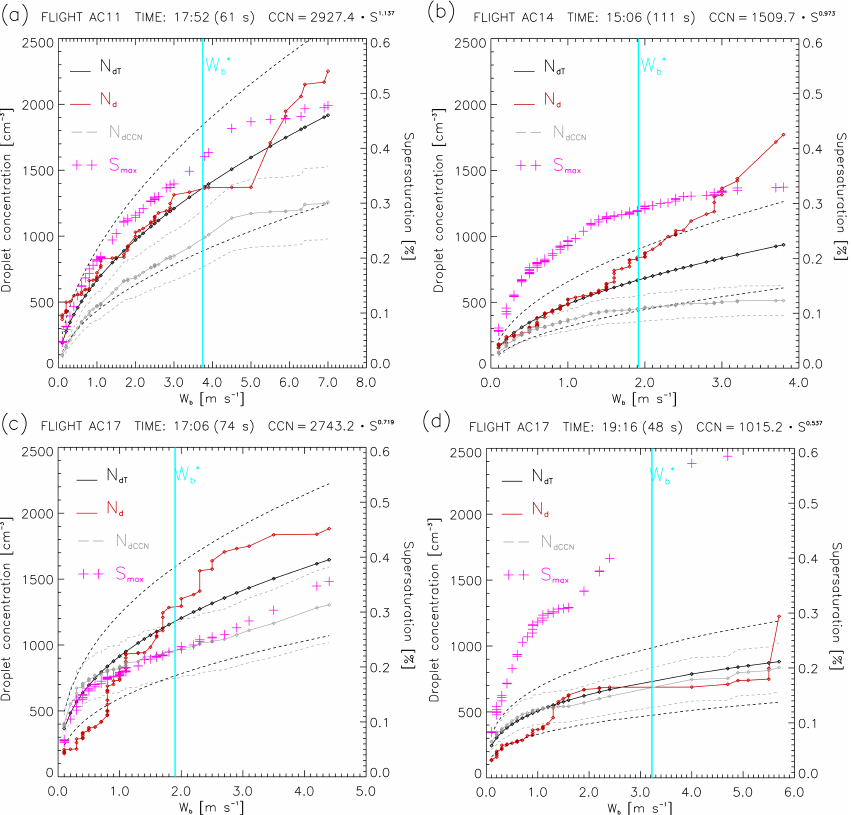
Figure 12. (a) – (d) The same as in Fig. 11 for the CCP-CDP probe. No data were available for flight AC16. The CCP-CDP malfunctioned in flight AC13 during the cloud base